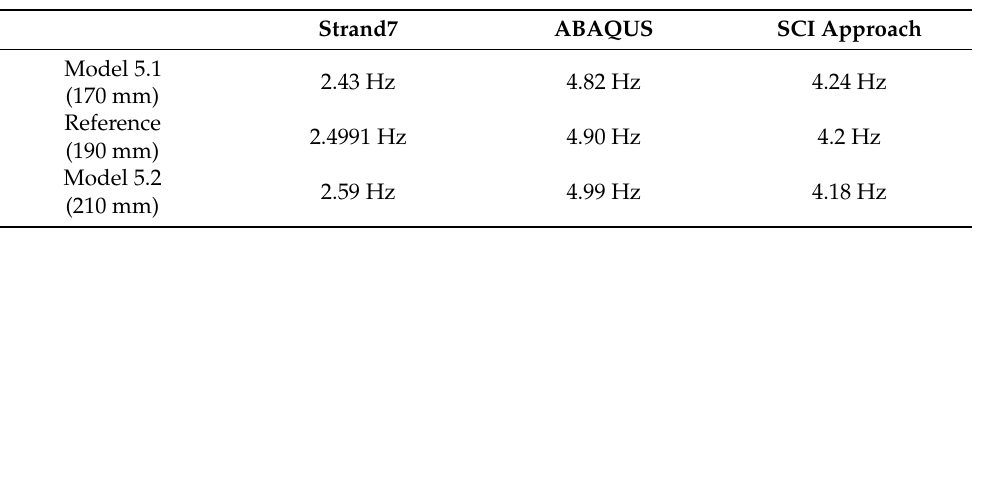
Table 10. Effect of Slab Depths to Fundamental